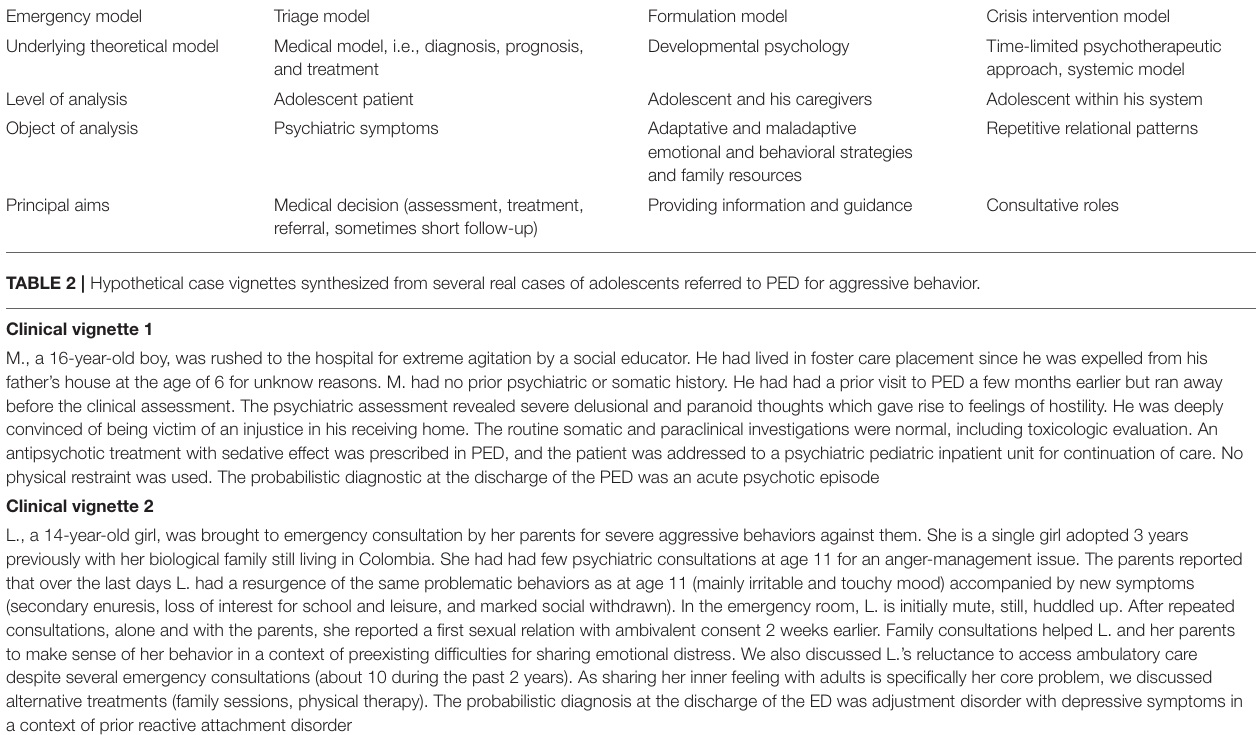
TABLE 1 | A proposed three-step approach for the assessment of adolescents with behavioral problems in ED.